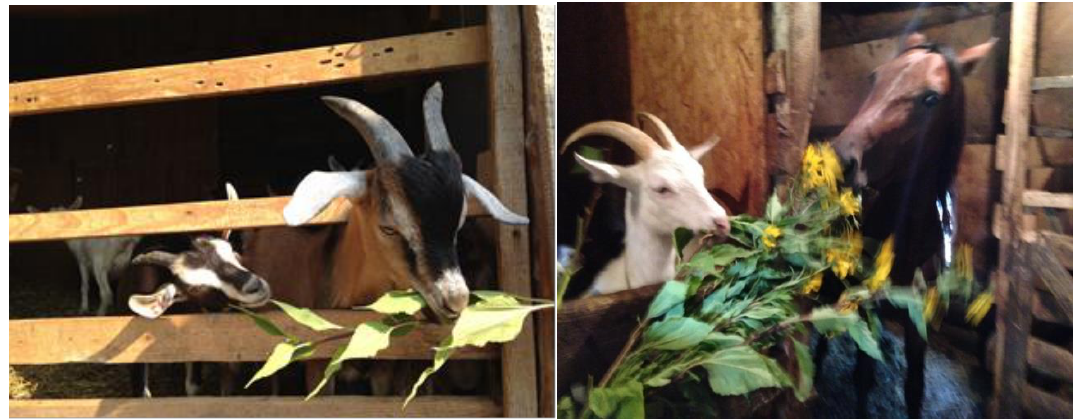
Figure 2. Artichoke green mass as a kickshaw (the farm household headed by E.I. Stroeva, an individual entrepreneur (village Serebrovo, Kameshkovskiy district, Vladimir region)).